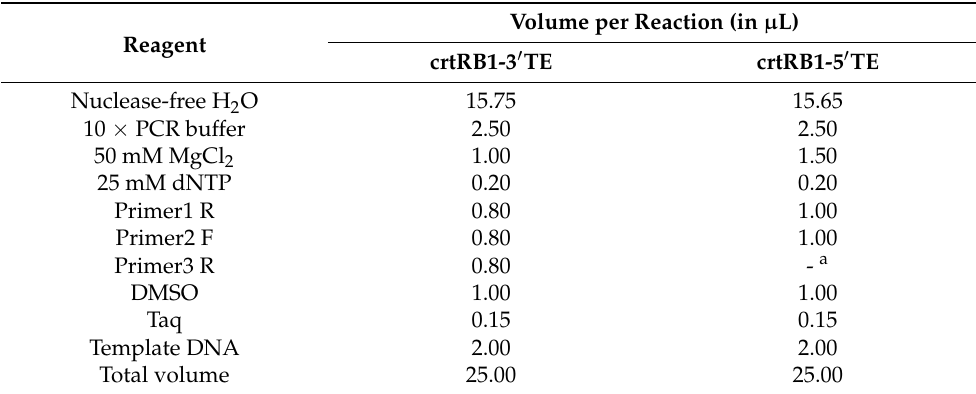
Table 1. Cocktail and reaction mix used for polymerase chain reaction. a Primer 3 R was not used under crtRB1-5 (cid:48)